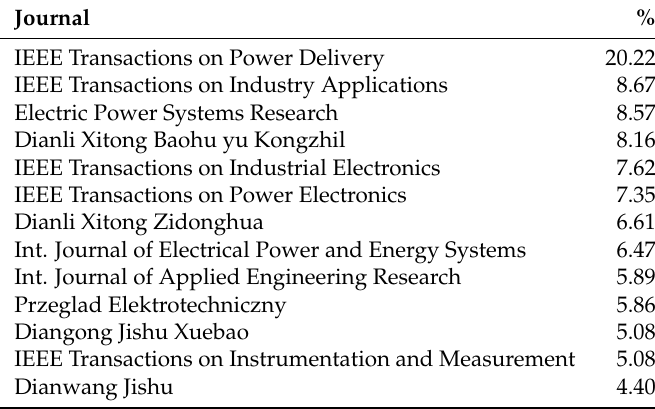
Table 2. Top journals publishing articles related to power